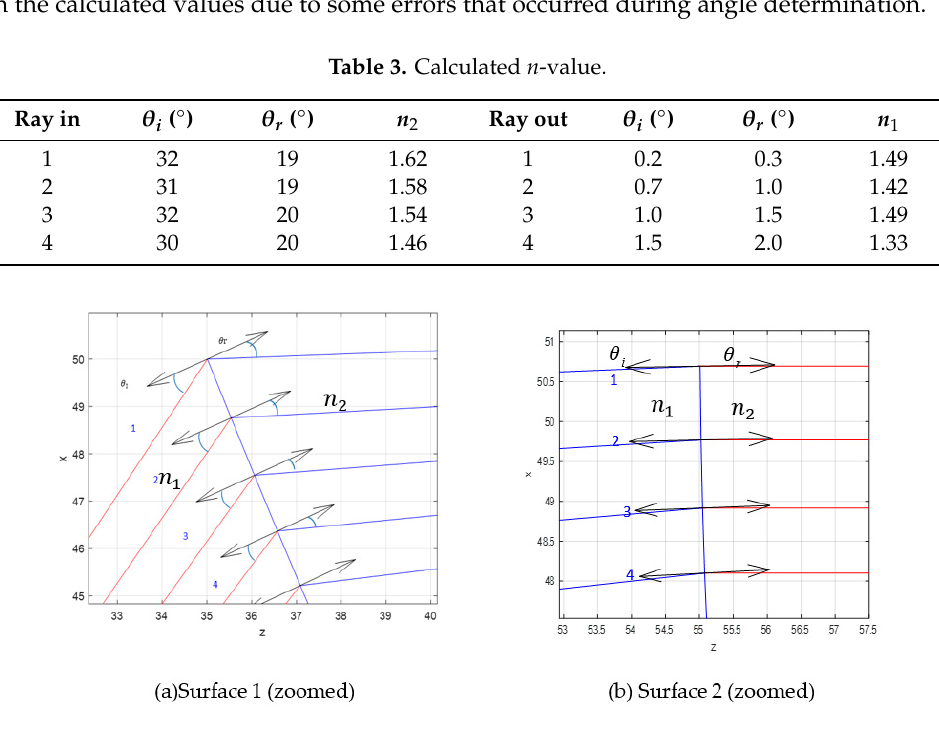
Figure 9. Rays in and rays out . Table 3. Calculated n -value.